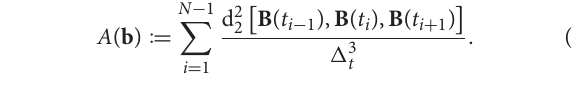
R with n 5 segments and = = S 2 with n 3 segments. = =